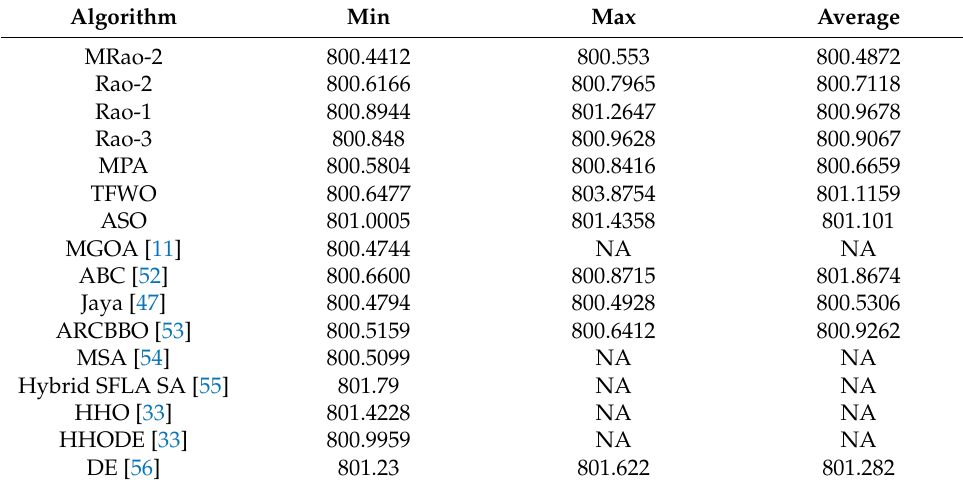
Table 5. Simulation results of MRao-2 and other algorithms for Case 1.